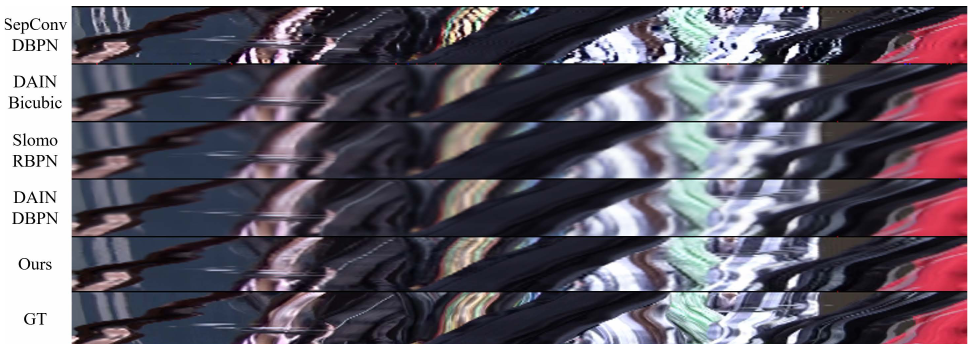
Figure 3. The x - t slice of the Walk scene in the Vid4 dataset, where x is the 220-th pixel